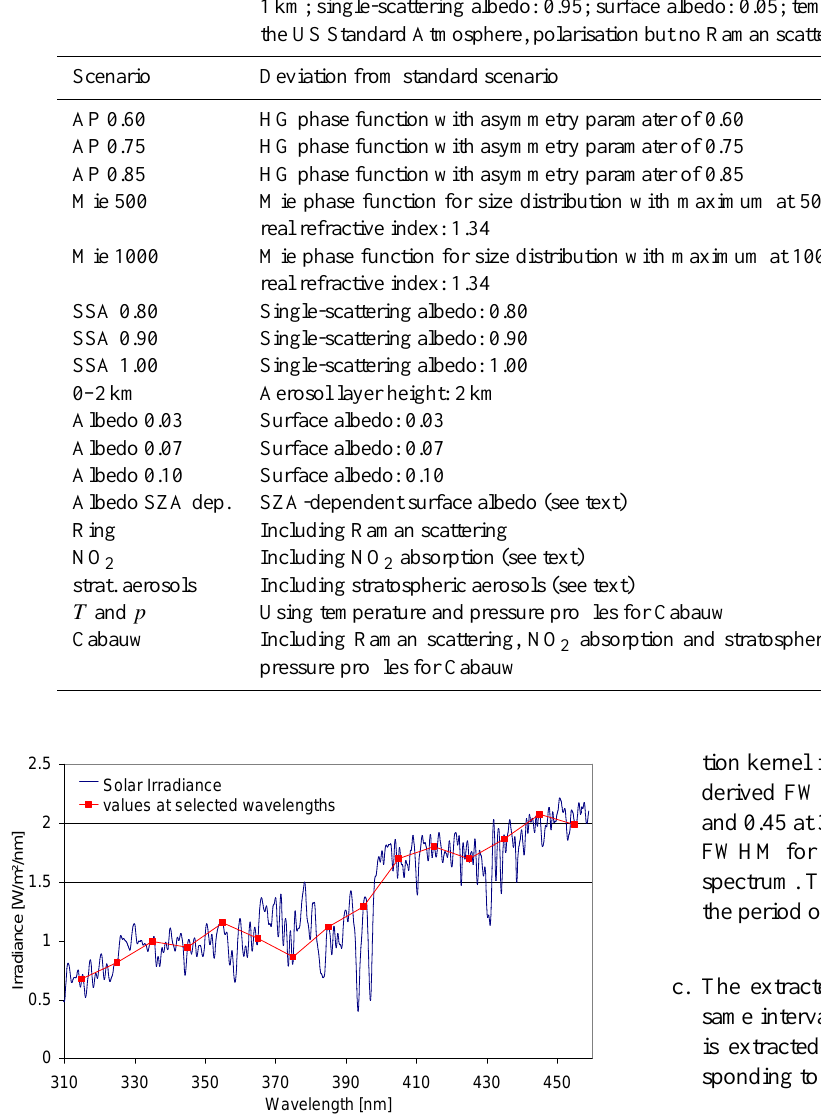
Figure 2. Convolved solar irradiance spectrum (blue line) and ex- tracted radiances at the specific wavelengths selected in this